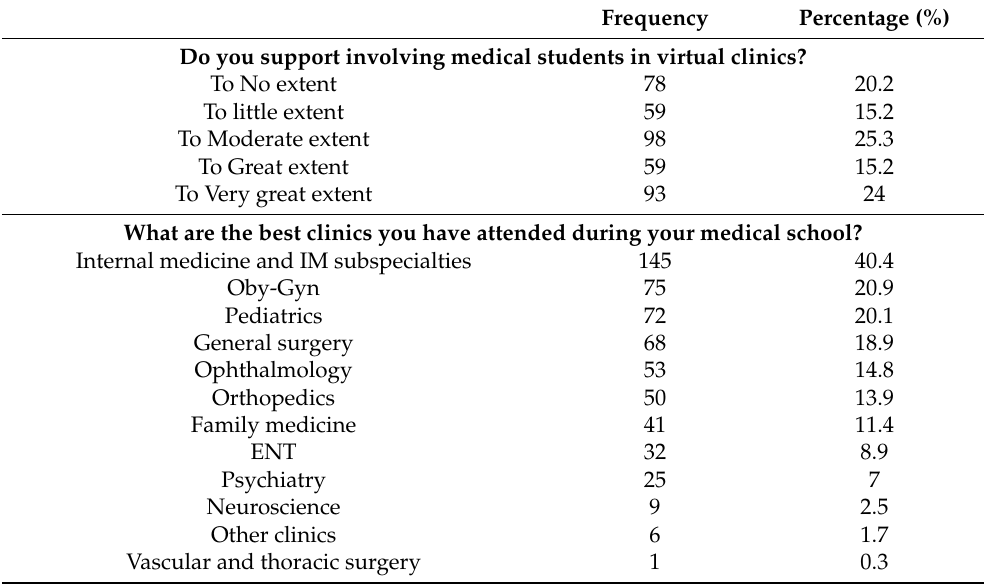
Table 2. Descriptive analysis of the medical students’ perceptions about virtual clinics and preferred clinics in ACC.